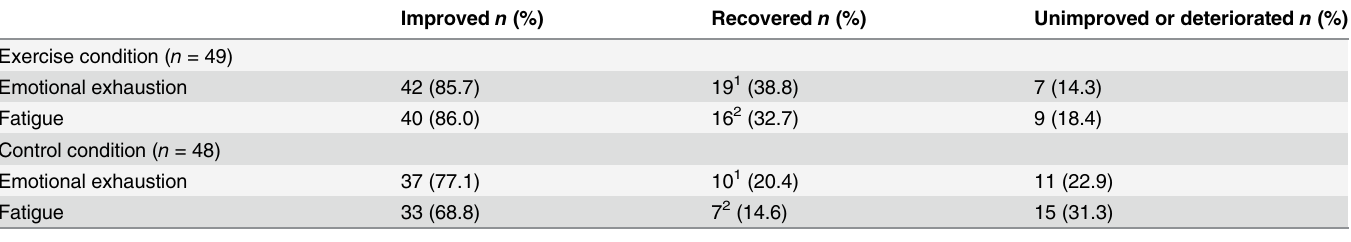
Table 3. Stability and change: percentages of participants who improved, recovered, unimproved or deteriorated on emotional exhaustion, and overall fatigue from T0 to